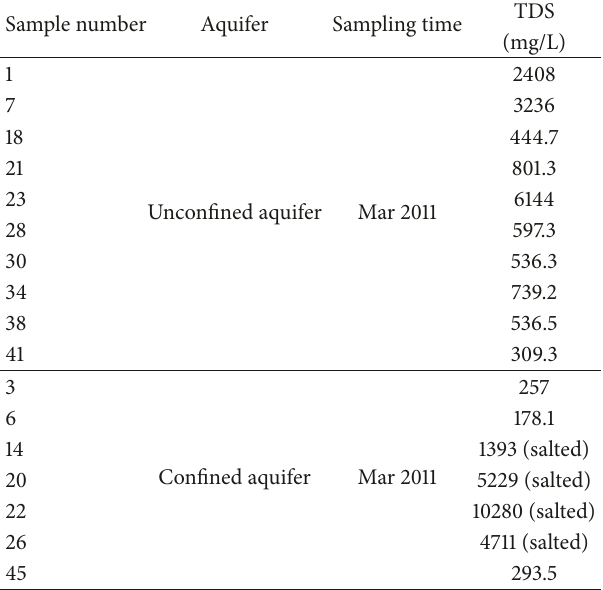
Table 5: Groundwater chemistry data of Naozhou island observed by Zhang et al.